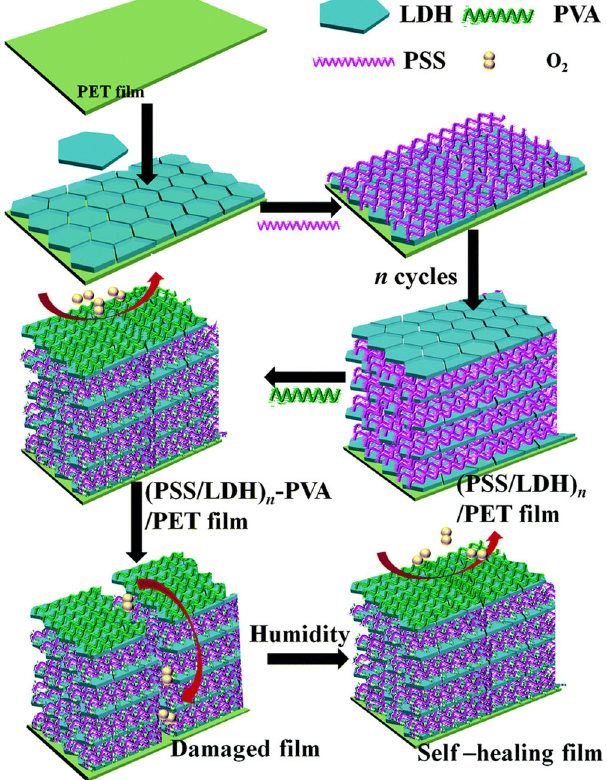
Fig. 3 The process of fabrication of a humidity-triggered self- healable fi lm on a polyester substrate. Reproduced from 28 with permission from Royal Society of